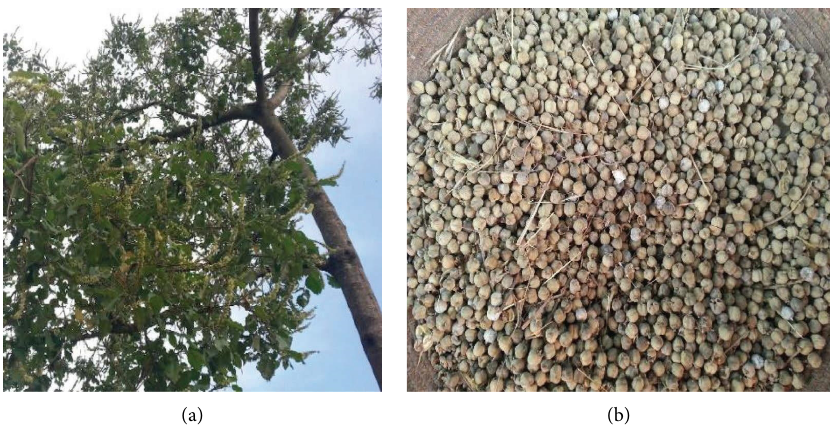
Figure 2: C. M hochst. ex delile (a) plant, (b) seed (own